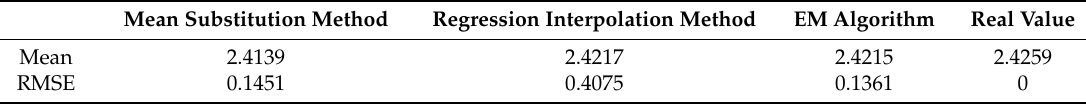
Table 3. Comparison of three data interpolation methods for a 30% missing rate. Table 2. Comparison of three data interpolation methods for a 20% missing